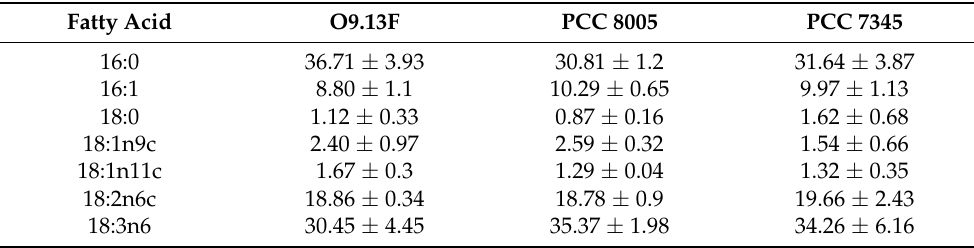
Table 1. Total FA composition (%) of Arthrospira strains O9.13F, PCC 7345 and PCC 8005 cultivated at 28 ◦